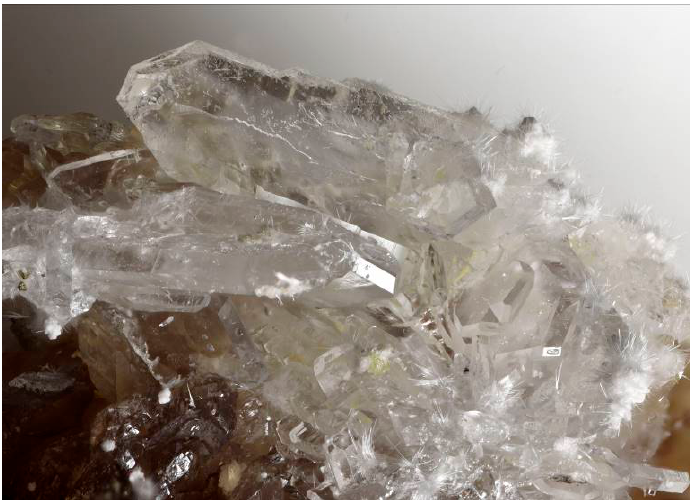
Figure 15. Khademite, colorless tabular crystals up to 3 mm with tufts of white halotrichite on krausite from the Monte Arsiccio mine.